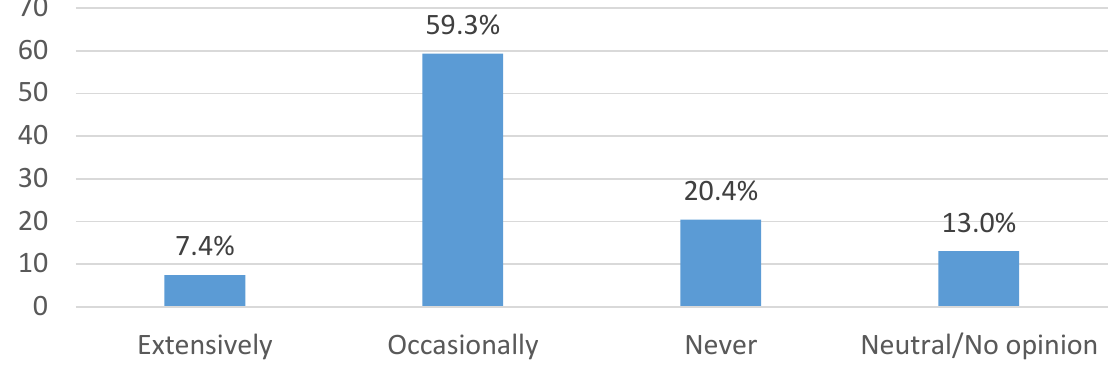
Figure 5. Staging the World Cup has negative impacts on the environment